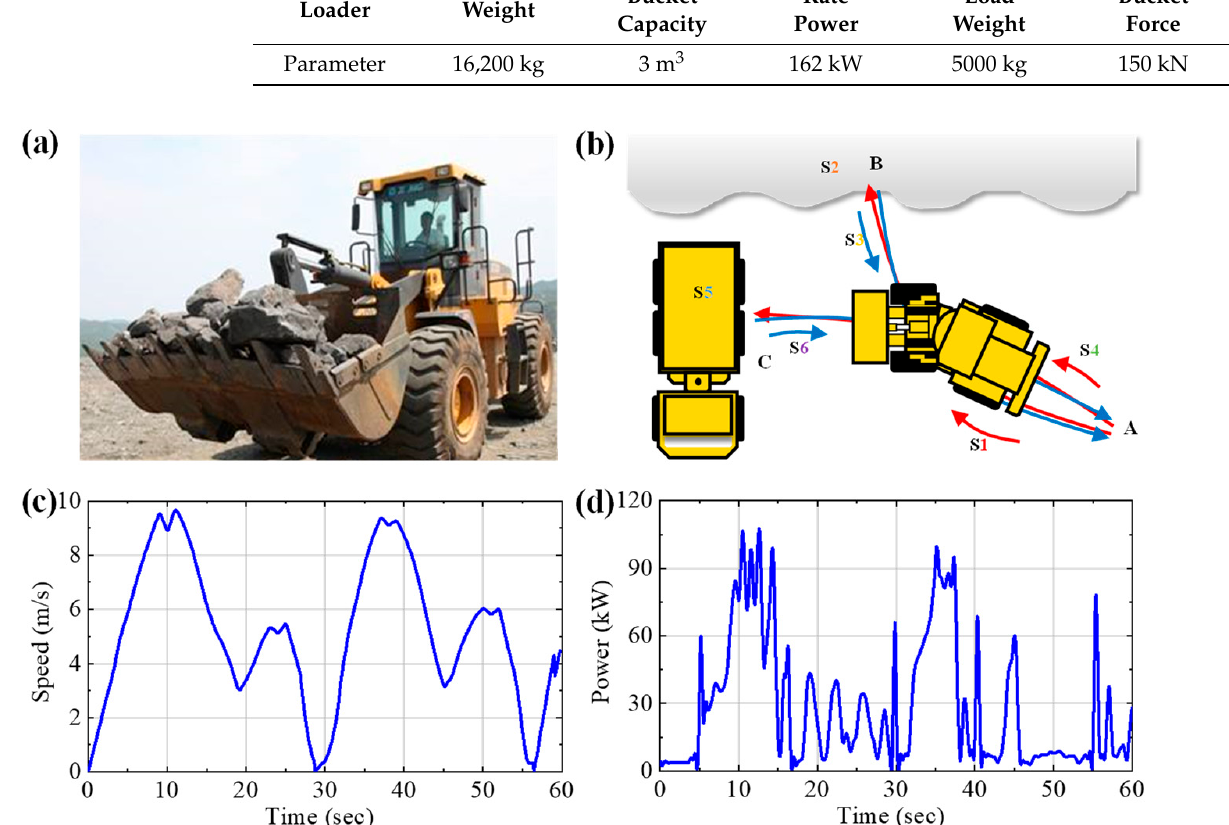
Figure 2. Power curve. ( a ) A 5-ton loader. ( b ) Experimental V-shape cycle. ( c ) Collected velocity curve. ( d ) Collected power curve.